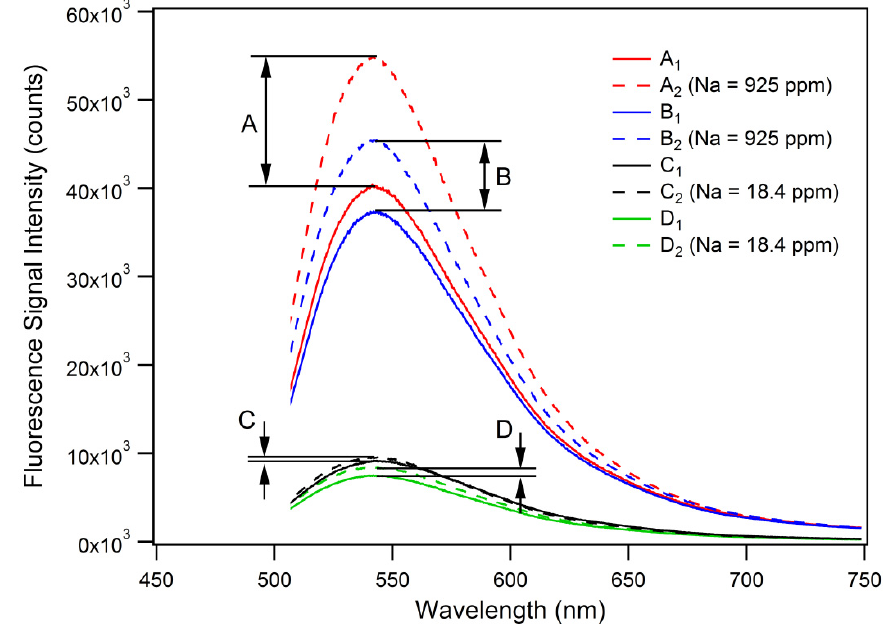
Figure 4. Fluorescence spectra of the PET-based MOF dip-sensors for analyte solutions, with and without sodium ions, showing the PET effect for small-volume (~0.1 µL) ion detection. Traces A and B represent background fluorescence spectra, whereas the 1 1 corresponding PET fluorescence spectra for Na + = 925 ppm are shown as traces A For Na + = 18.4 ppm, traces C and D are the background fluorescence spectra, and traces 1 1 C and D depict the corresponding PET-fluorescence spectra. Fluorescence 2 2